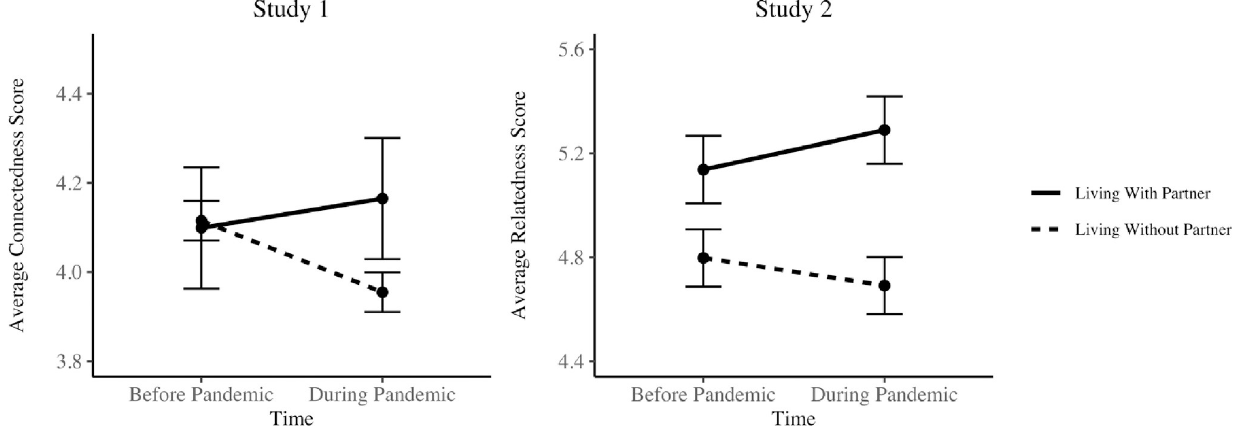
Fig 1. Changes in social connection for those living with and without partners in Study 1 (left) and Study 2 (right). Note . Across both Study 1 and Study 2, those living with a partner reported greater increases in social connection from before the pandemic (Time 1 ) to during the pandemic (Time 2 ) than those not living with a partner. Error bars represent 95% Confidence